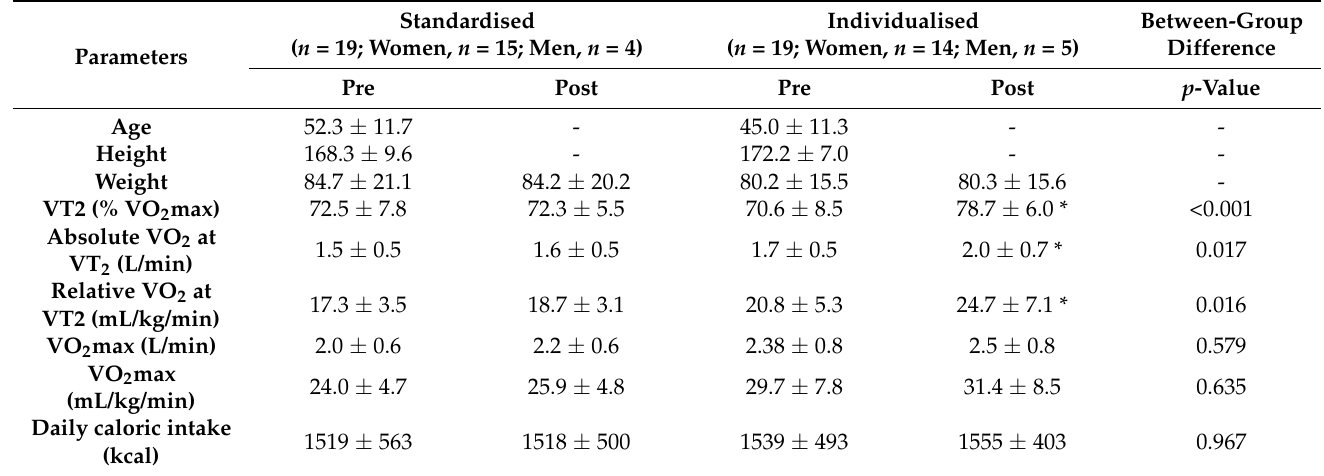
Table 1. Pre- and post-mean outcome measures for standardised and individualised exercise groups.